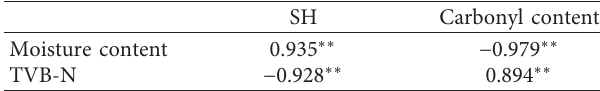
Table 3: Correlation between protein and quality. SH